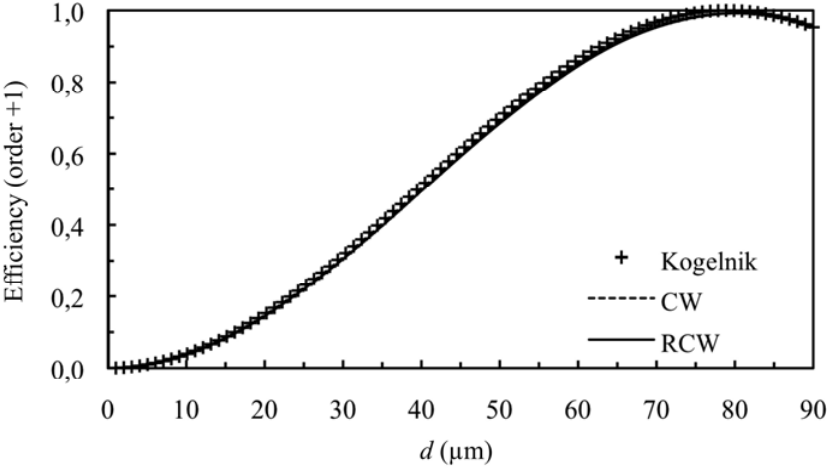
Figure 2. Efficiency of order 0 (zero order diffracted), at first Bragg’s angle. The spatial frequency is 350 lines/mm and the refractive index modulation is n